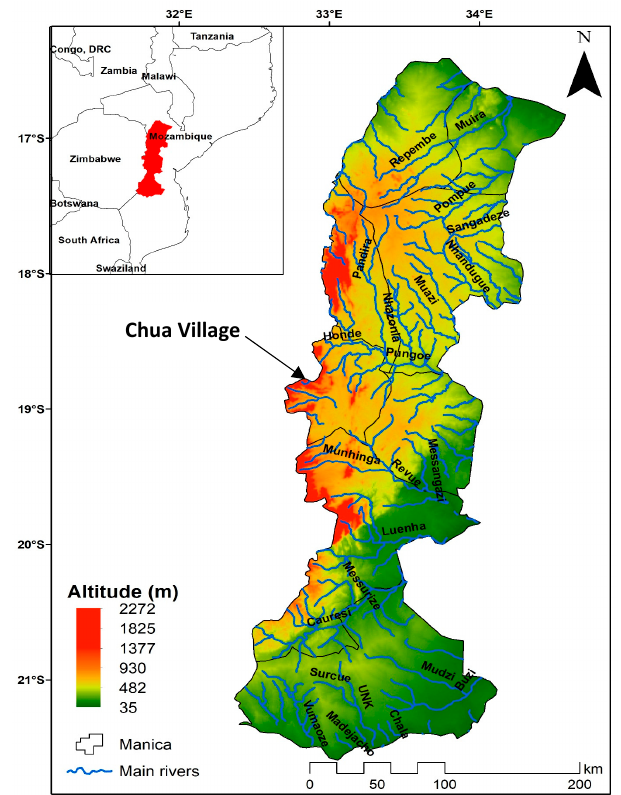
Figure 4. Major river basins, topography of Manica Province, and location of Chua Village. Source: own illustration.